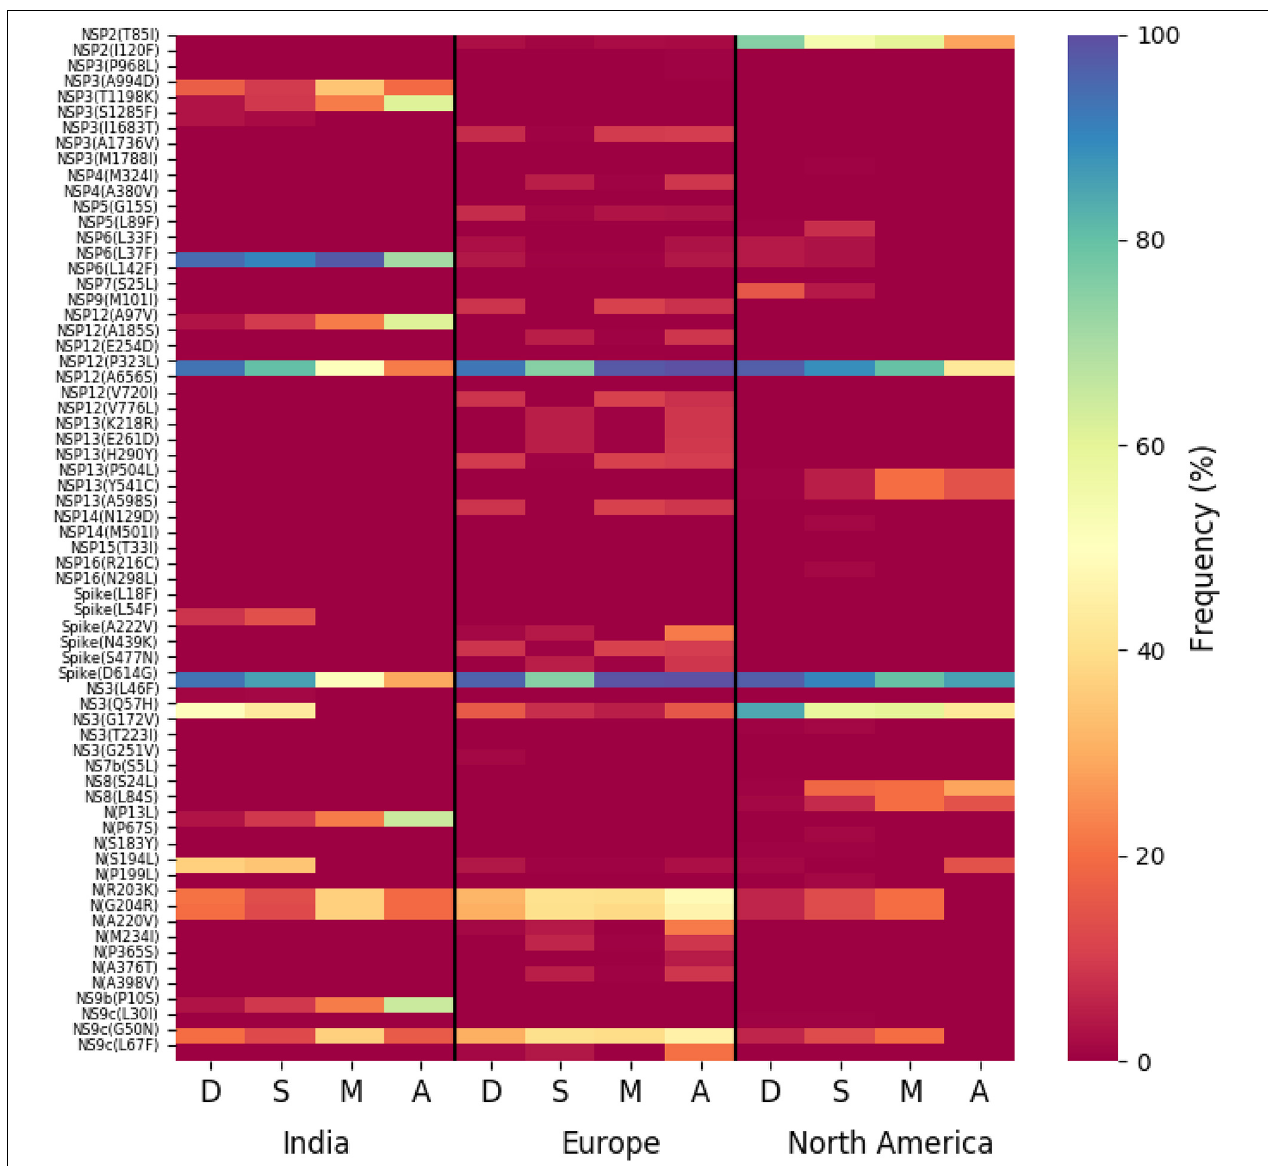
FIGURE 6 | Association of specific mutations with the status of the COVID-19 patients from India, Europe, and North America. A heat map of mutations and their frequencies that were found to be associated with four different categories of the status of the COVID-19 patients—deceased (D), symptomatic (S), mild (M), and asymptomatic (A), respectively—is